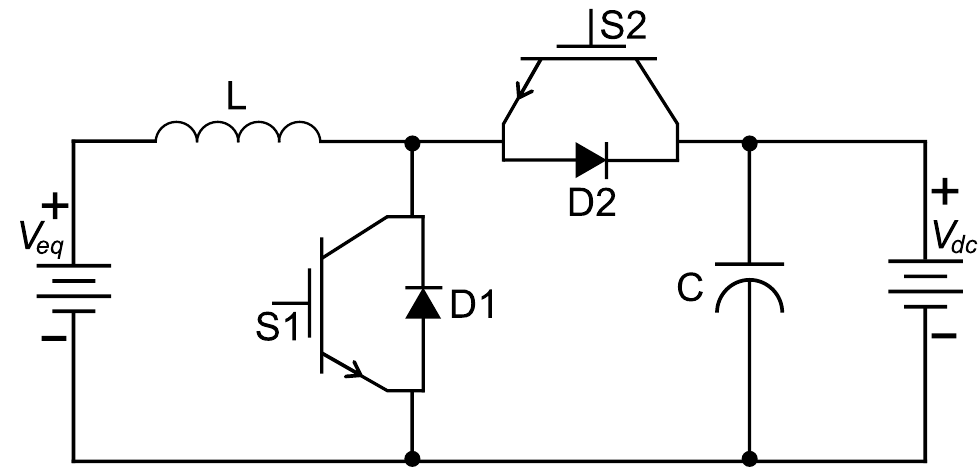
Figure 6. Bidirectional buck – boost converter diagram.